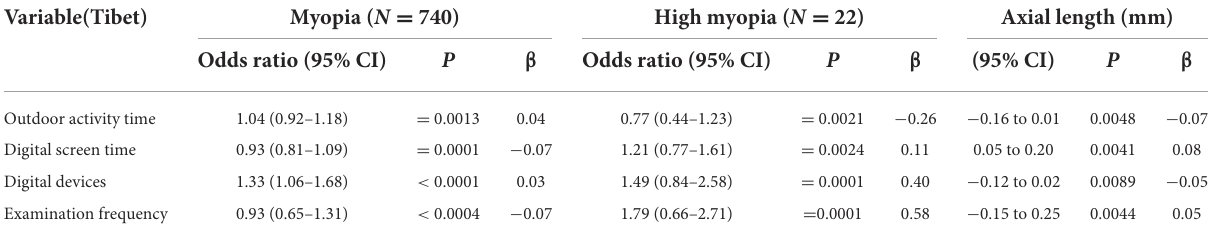
TABLE 4 Multivariate logistic regression results for myopia and high myopia in